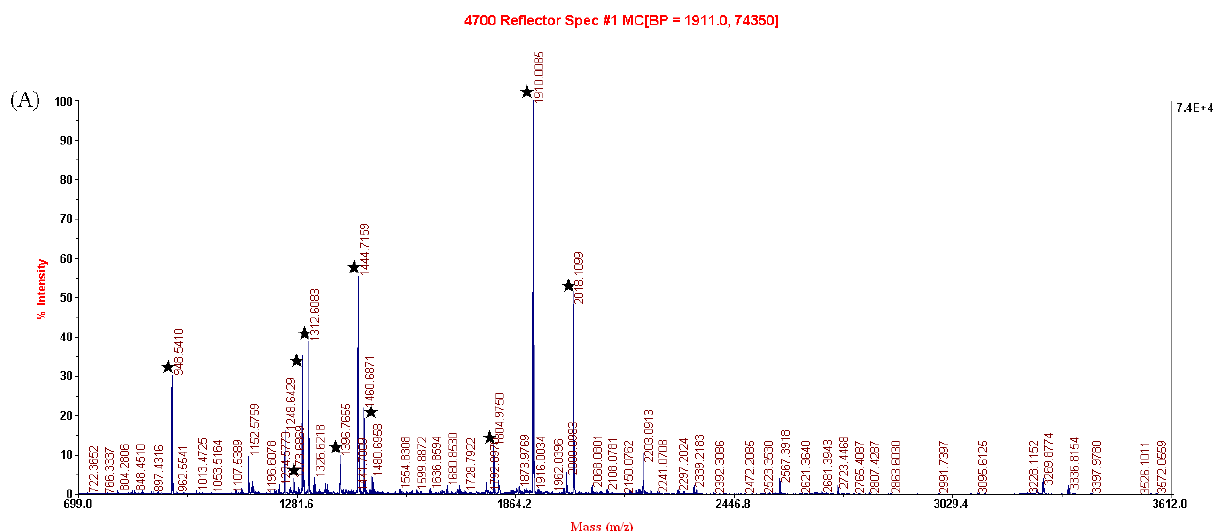
Figure 4. MALDI-TOF MS/MS spectra of the spot 201 cut from the 2-DE gel. ( A ) Peptide mass fingerprint (PMF) of the tryptic digest of spot 201. Peptide signals identified were marked with asterisks; and ( B ) MS/MS profile of the peptide with a mass of 1444.72